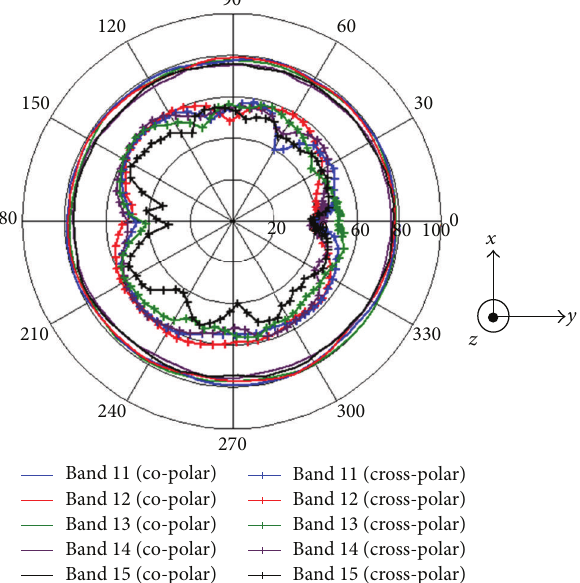
Figure 9: Measured H-plane radiation patterns (co-polar & cross- polar) at operating frequency, 𝑓 , for TMFDB25 with stubs 1, 2 at bands 6 to 10.